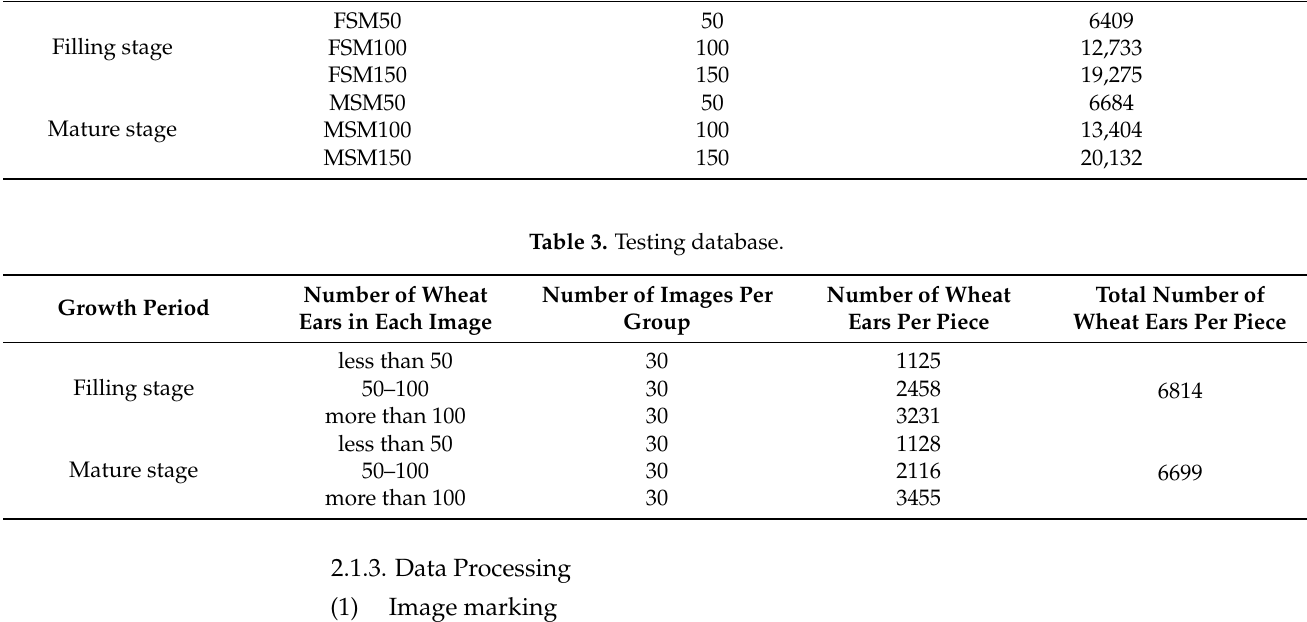
Table 3. Testing database.